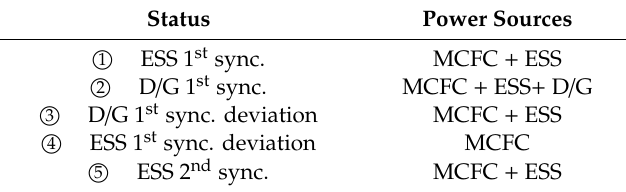
Table 7. Synchronization condition in normal seagoing case 2. Figure 14. Synchronization and system deviation for load pattern of normal seagoing case 2.